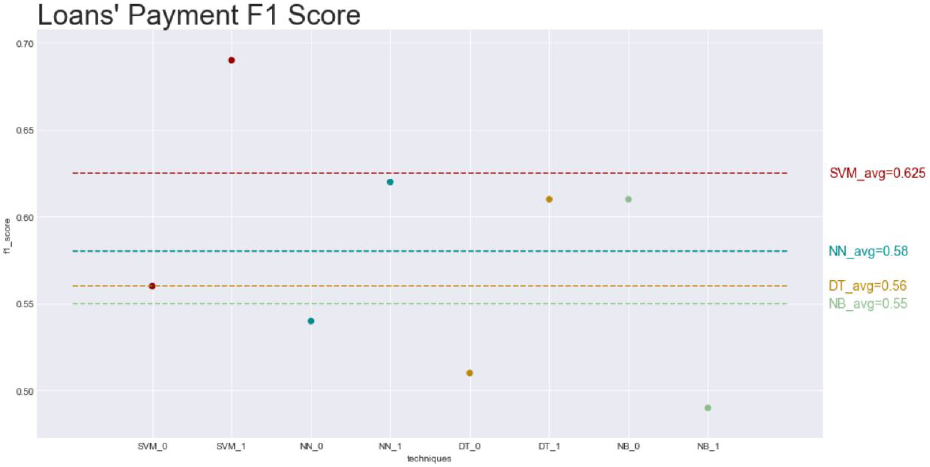
Figure 6. Variation of the F1 Score in the different algorithms